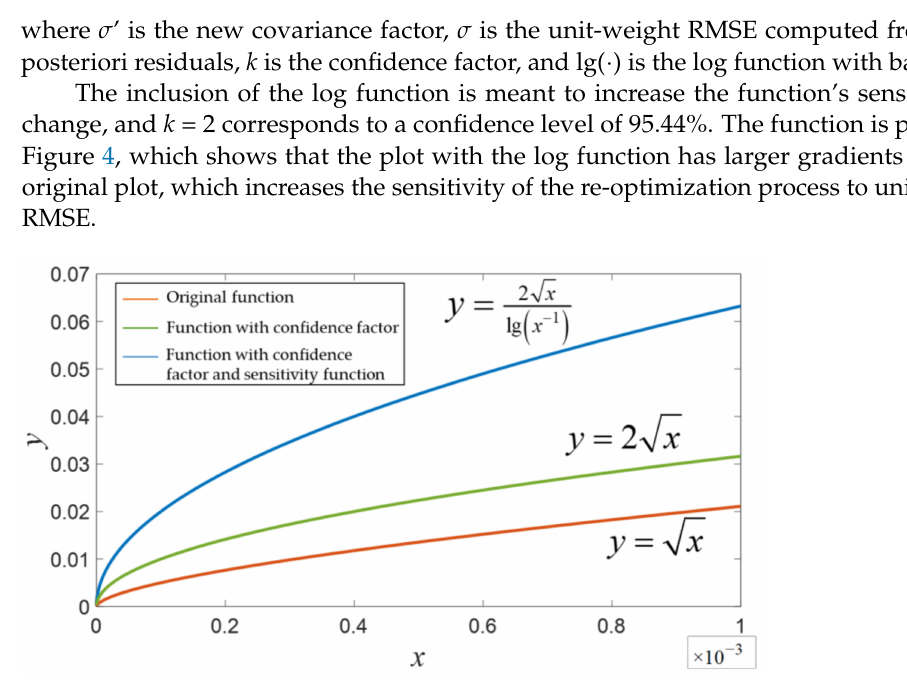
Figure 4. The covariance tuning